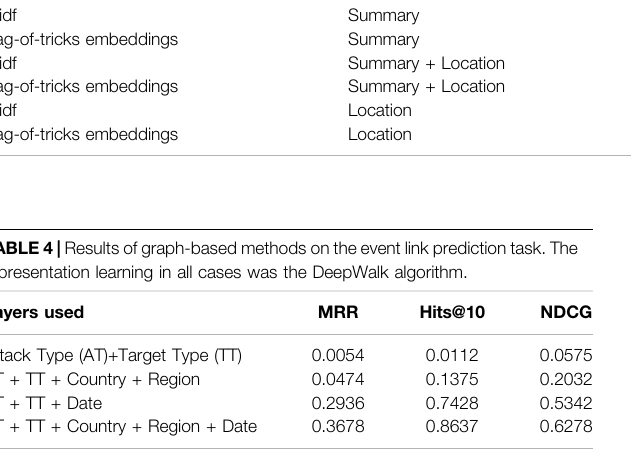
TABLE 3 | Results of text-rich systems on the event link prediction task. Metrics are described in Section 3.4 . In all cases below, the ranking is generated using the cosine similarity function between the vectors. Representation method